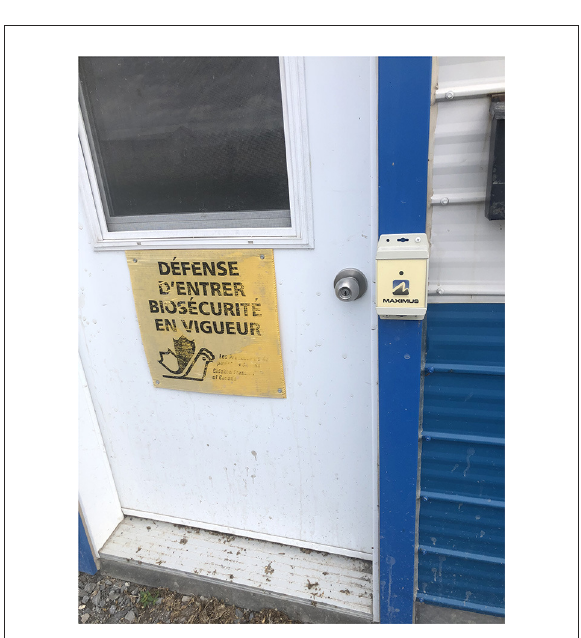
FIGURE5 First antenna in the frame of the exterior door identifying the person entering the barn using the Maximus prototype.